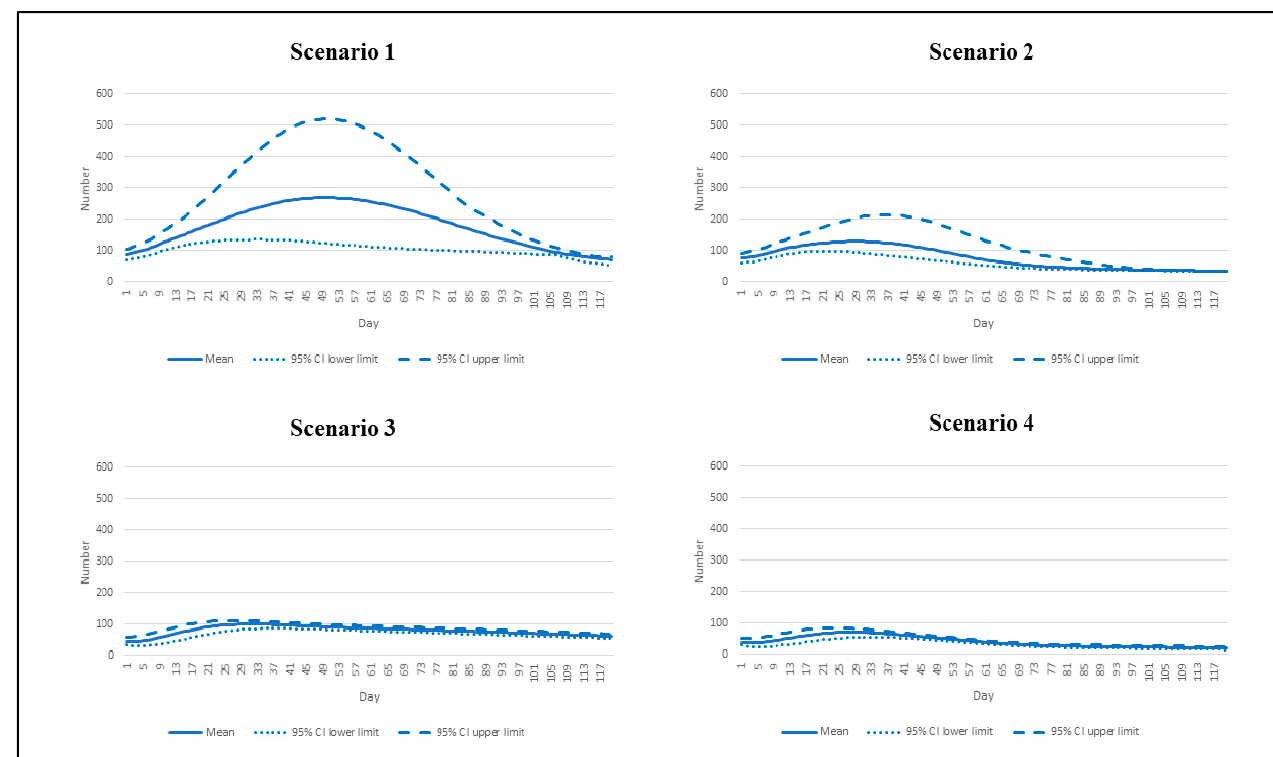
Figure 3. Daily deaths by different epidemic scenarios. The prevalence of intubated cases followed the same pattern as the daily deaths.